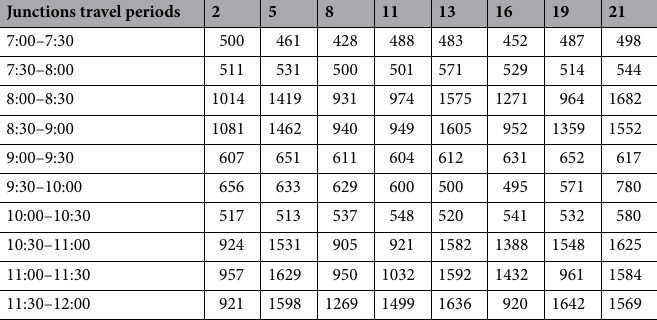
Table 6. The traffic flow of the social